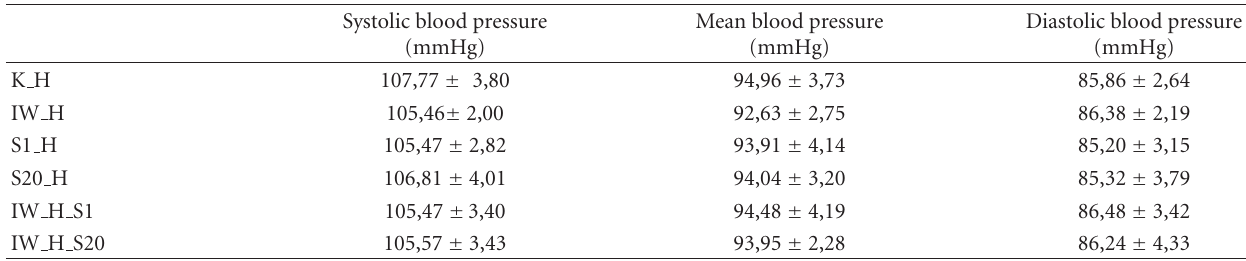
Table 4: Summary statistics (mean ± SD) for blood pressure (mmHg) in hypercholesterolaemic rats. Systolic blood